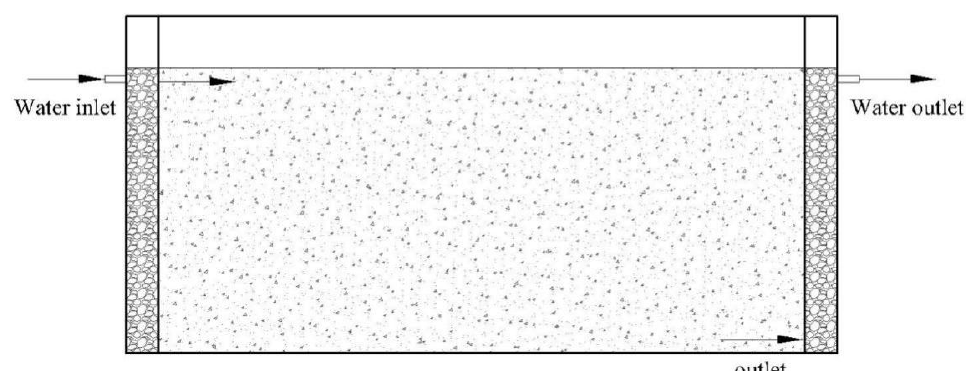
Figure 1. Schematic diagram of wastewater treatment device.